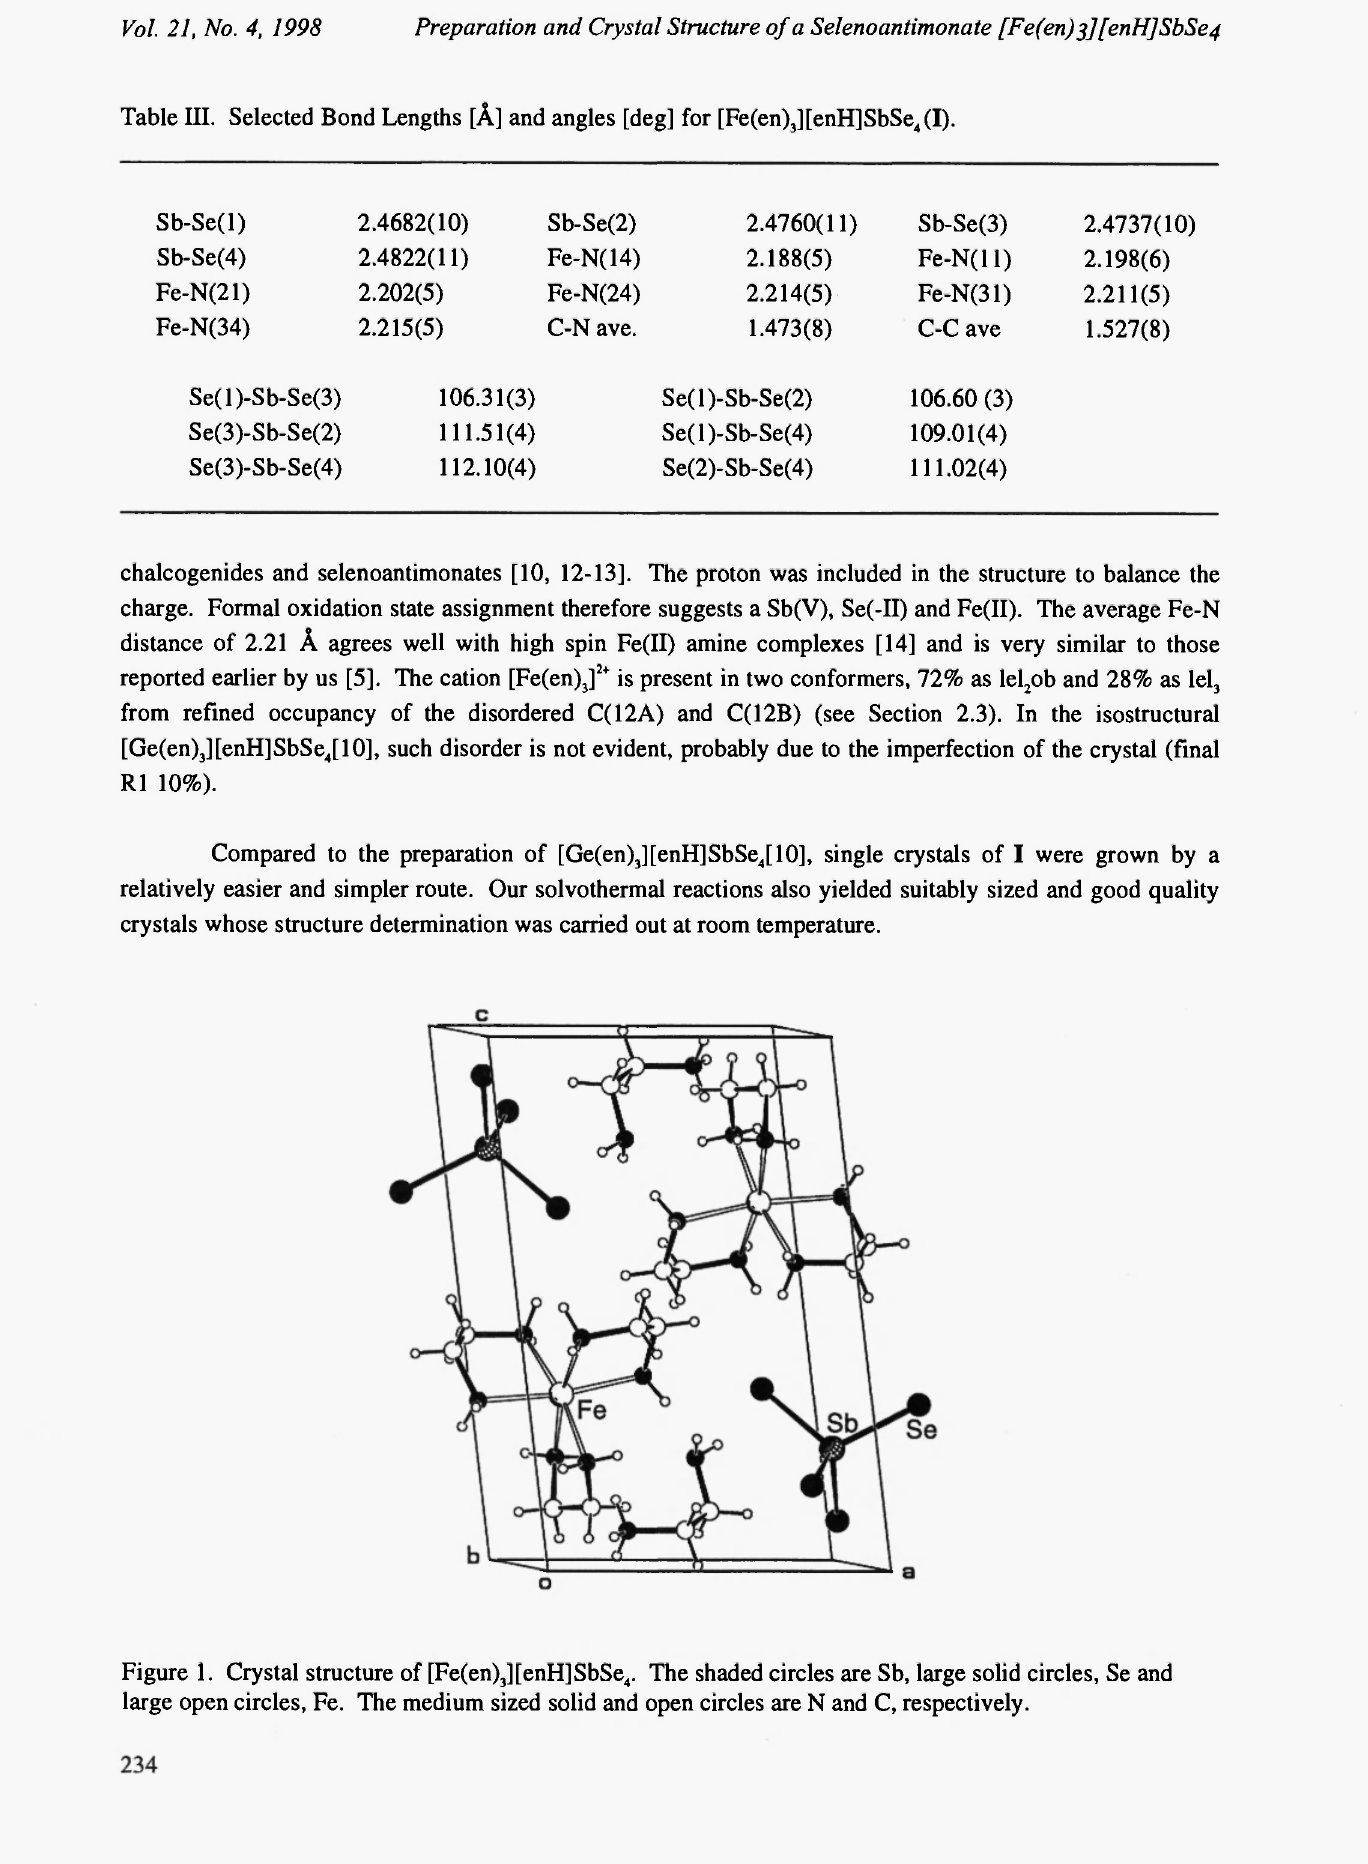
Figure 1. Crystal structure of [Fe(en) large open circles, Fe. The medium sized solid and open circles are Ν and C,